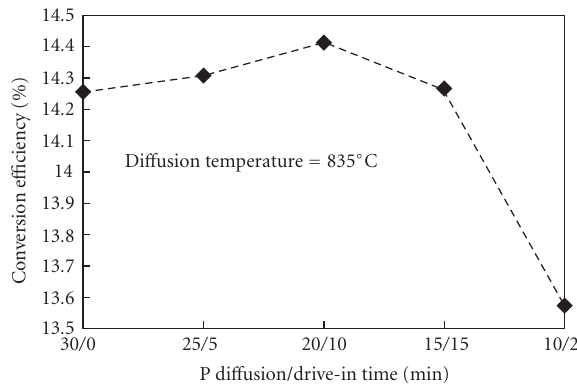
Figure 3: The conversion e ffi ciency of the sc-Si prototype using same total 30-minute di ff usion with the di ff erent drive-in